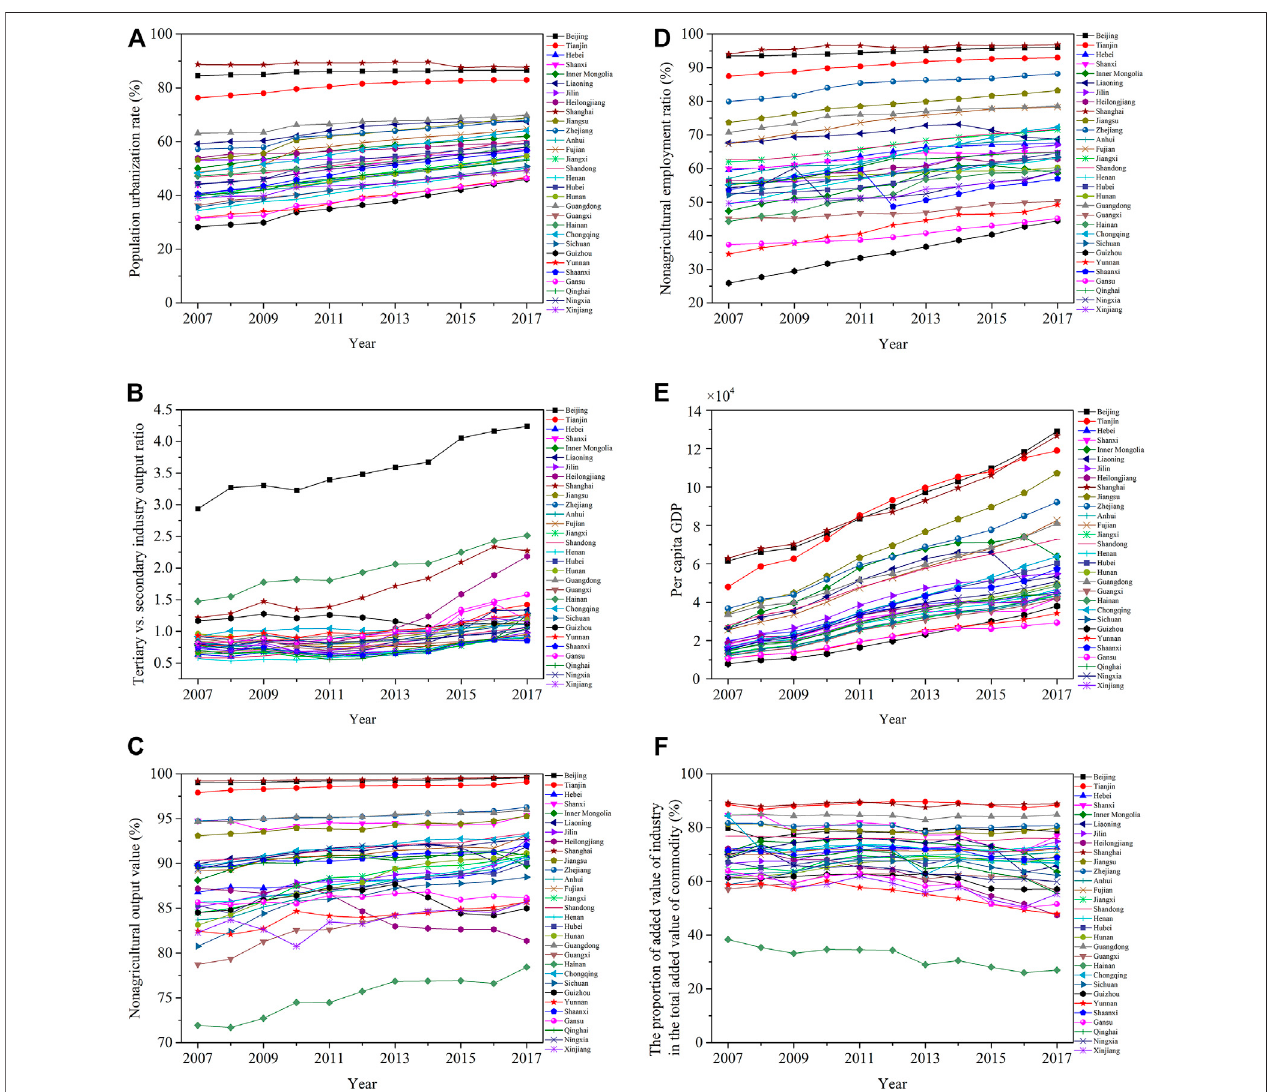
FIGURE 1 | Trends of different socioeconomic development (SED) indicators in 30 regions of China from 2007 to 2017.